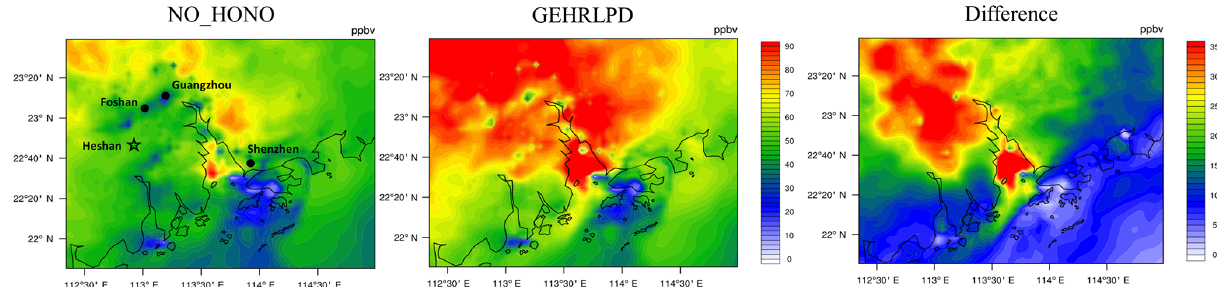
Figure 7. Spatial distributions of O 3 mixing ratios at 15:00LT simulated in the NO_HONO and GEHRLPD cases and their difference for domain